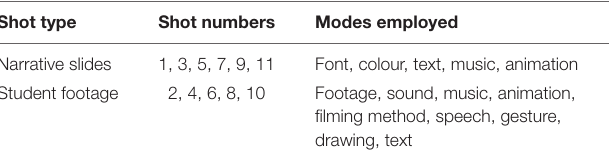
TABLE 2 | Distribution of meaning across shot types in Jay and Terry’s Digital